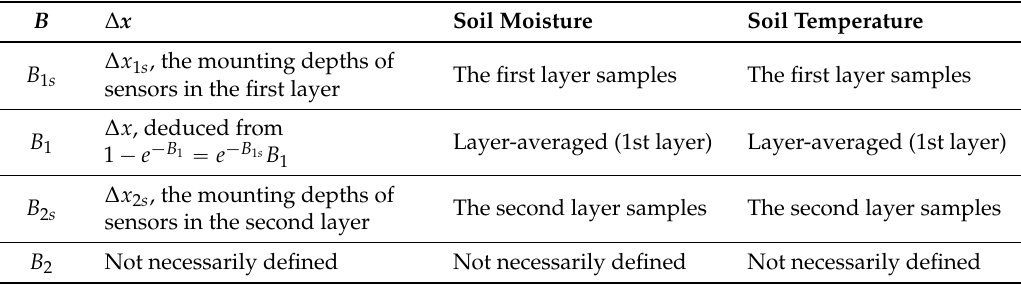
Table 2 explains the definition of parameters used in determining the optimal mounting depths. To keep consistent with the B 1 in Equation (3), B 1 s and B 2 s are proposed to stand for the corresponding B values at the mounting depth of ∆ x 1 s and ∆ x 2 s , where the sensors are installed. Table 2. The explanation of the parameters used in determining the optimal mounting